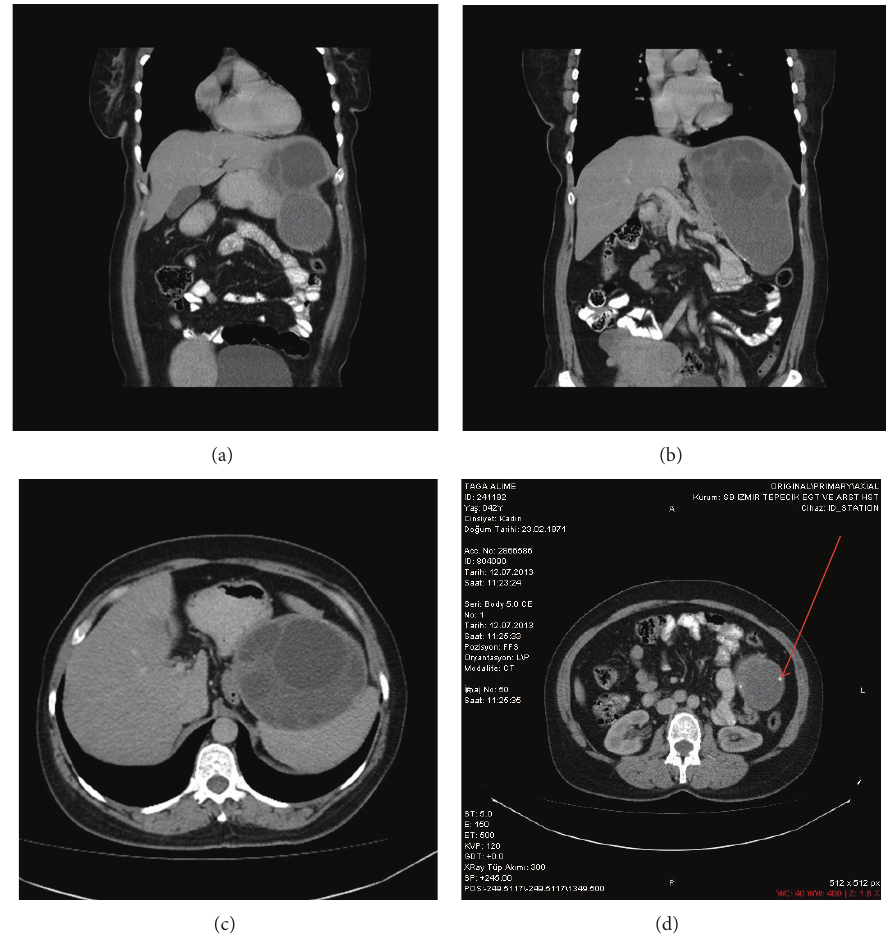
Figure 1: (a) The coronal CT image of bilobar hydatid cyst lesion. (b) The coronal CT image of multiple daughter cysts. (c) The axial CT image of multiple daughter cysts. (d) The axial CT image of inferior portion of the cyst that the red arrow shows the cystic wall